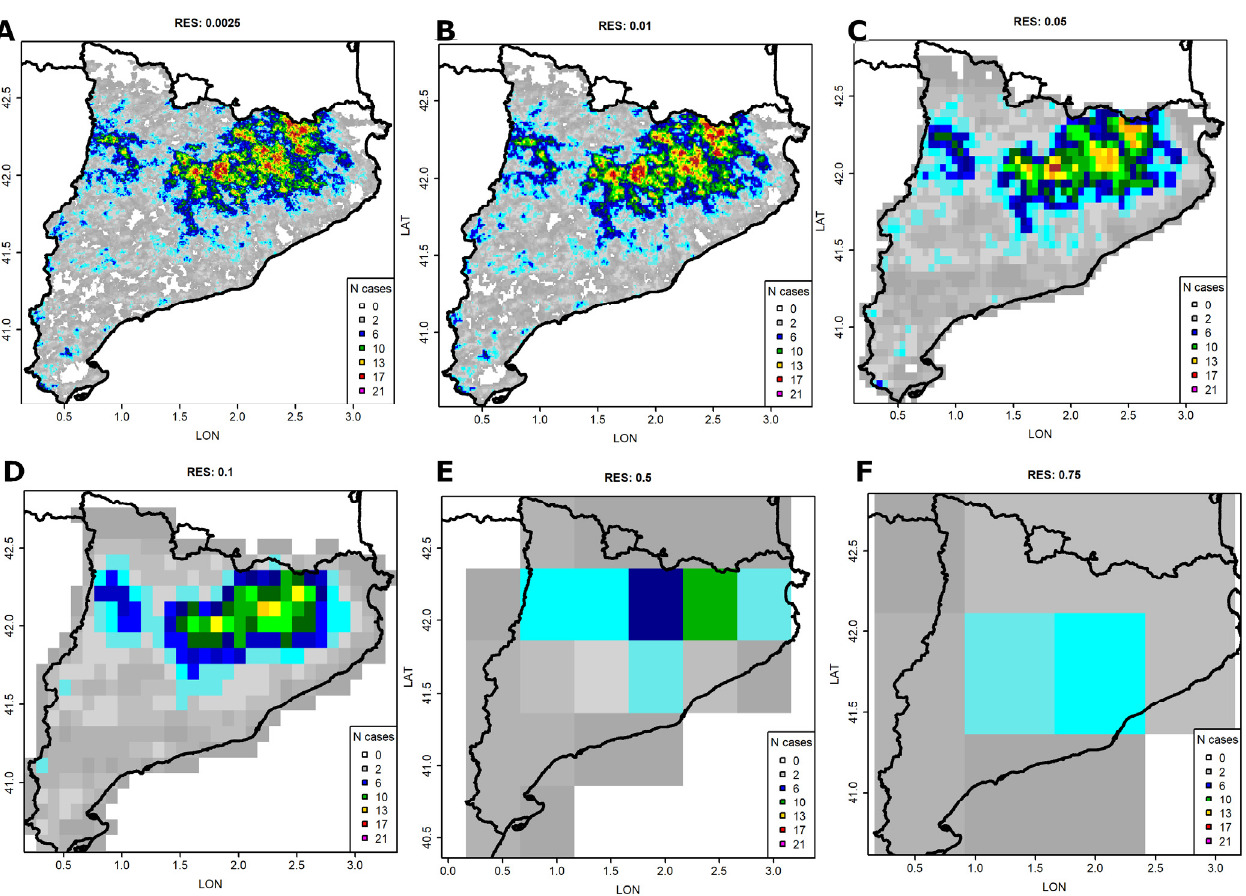
Figure 6. As in Figure 4 but for the hail occurrence according to the radar data (VIL > 20 mm), and for the period 2013–2022. for the period